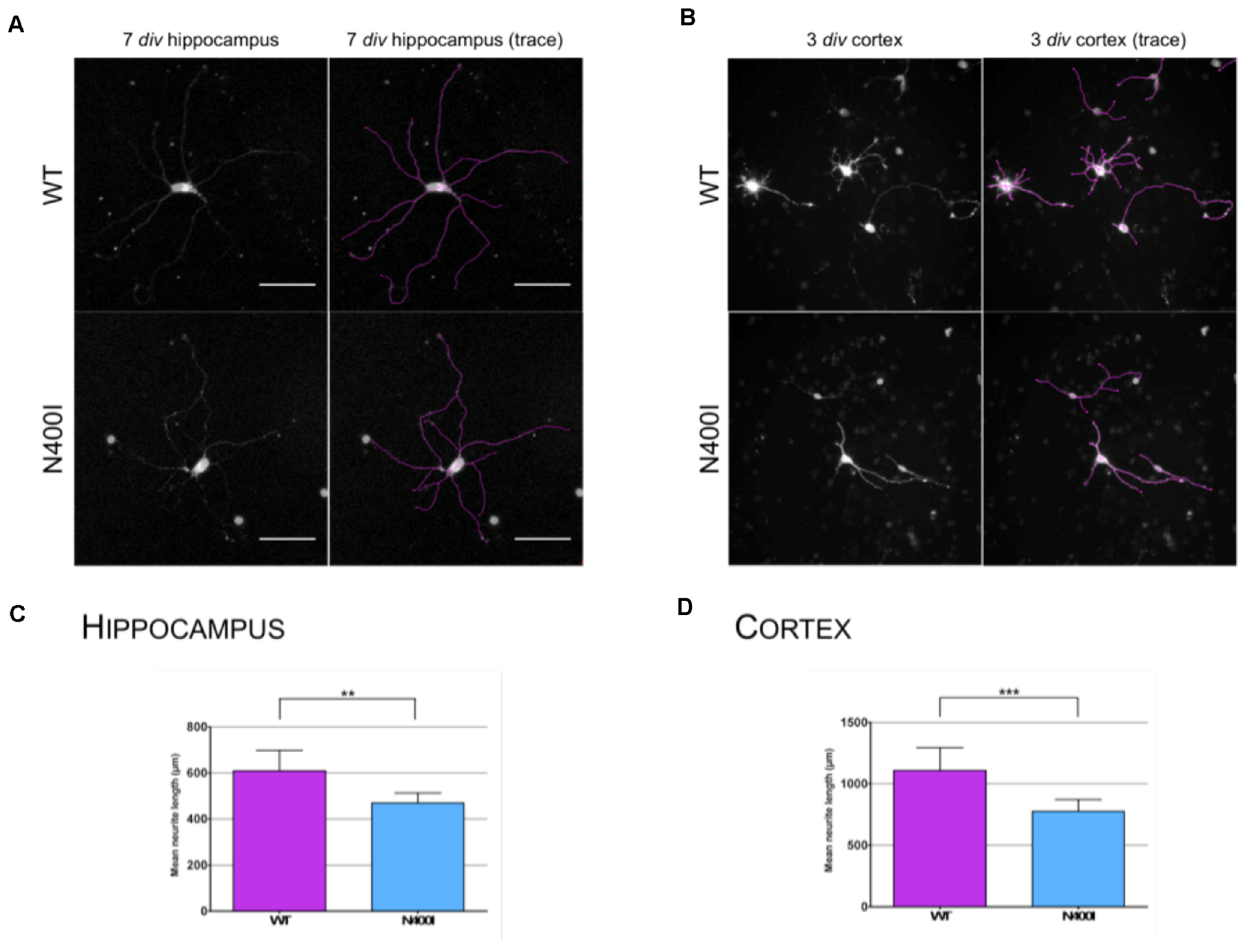
Figure 3. SLITRK1 variant N400I fails to induce neurite outgrowth. ( a ) LS: Representative images of primary rat E18 hippocampal neurons nucleofected with wildtype SLITRK1 or the SLITRK1 –N400I variant. RS: Images are also traced to facilitate visualization of thin neurites. Scale bar=50 m m ( b ) LS: Representative images of primary mouse E17 cortical neurons nucleofected with wildtype SLITRK1 or the SLITRK1 –N400I variant. RS: Representative E17 cortical neuron trace. Scale bar=50 m m ( c ) The summed total neurite length per hippocampal neuron at 7 div is shown. Each bar on the bar graph represents pooled data of at least 50 neurons per experiment ( n =3). Images are uniformly overexposed to improve neurite visibility. ( d ) The summed total neurite length per cortical neuron at 3 div is shown. Each bar on the bar graph represents pooled data of at least 14– 22 neurons per experiment ( n =2). Statistical significance was assessed using a student’s t-test as described under Materials and Methods. Error bars are 95% confidence intervals. * p , 0.05, ** p , 0.01, *** p ,